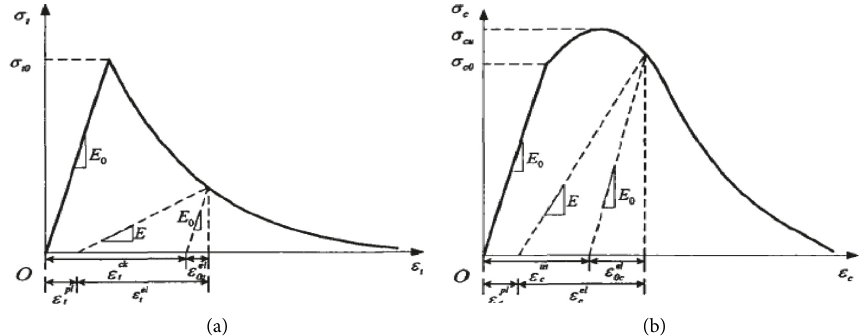
Figure 6: CDP model. (a) Uniaxial tensile stress-strain curve. (b) Uniaxial compressive stress-strain